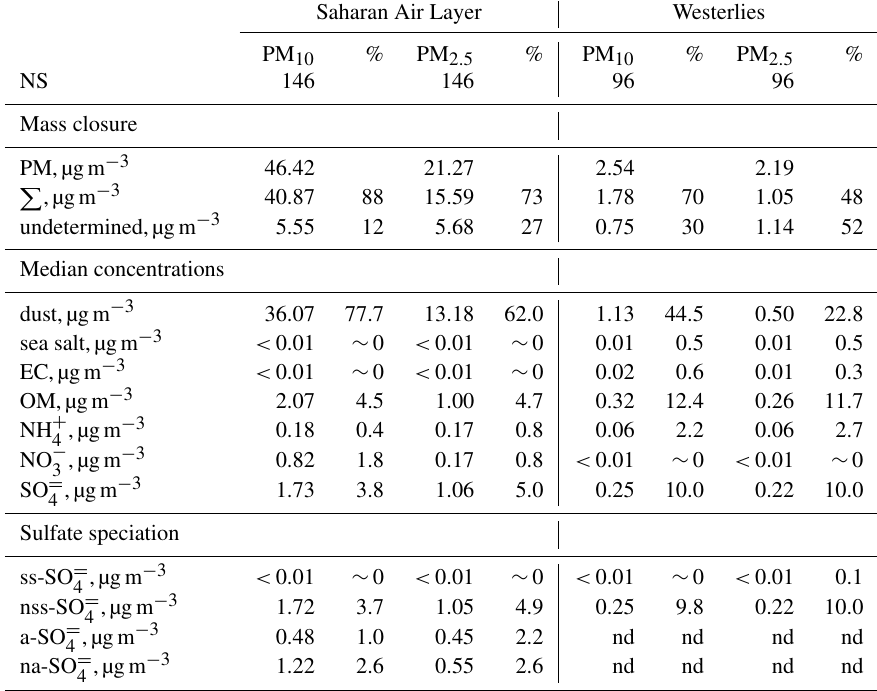
Table 1. Mass closure and median concentrations of PM 10 and PM 2 . 5 components in samples collected when Izaña was (i) within the Saharan Air Layer (SAL) and (ii) within the westerlies (WES). Only days when PM 10 and PM 2 . 5 were sampled simultaneously were taken into account. The percentage of the corresponding parameter with respect to the PM is